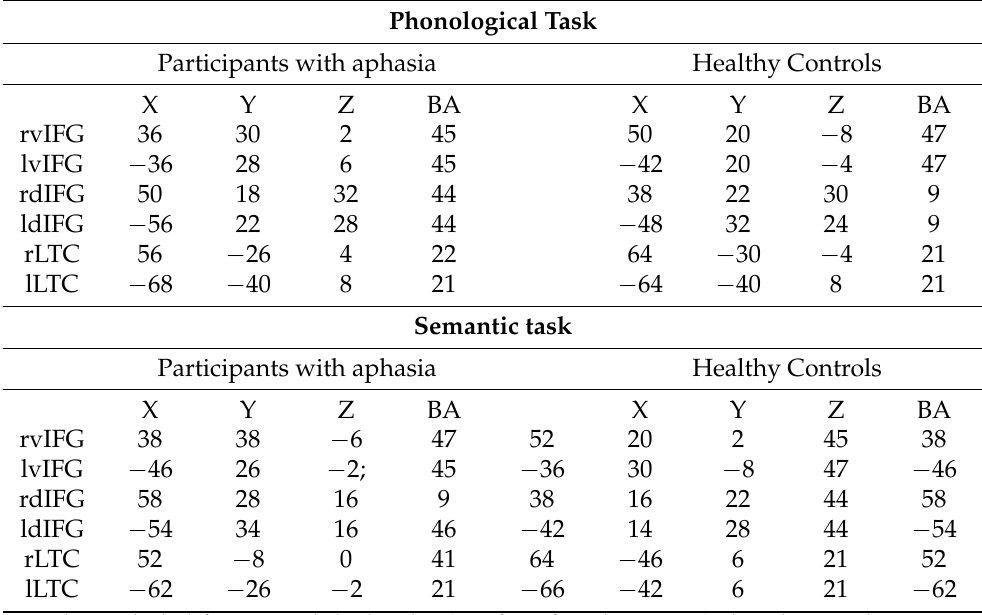
Table 2. Group coordinates used as reference for VOI selection in each group and